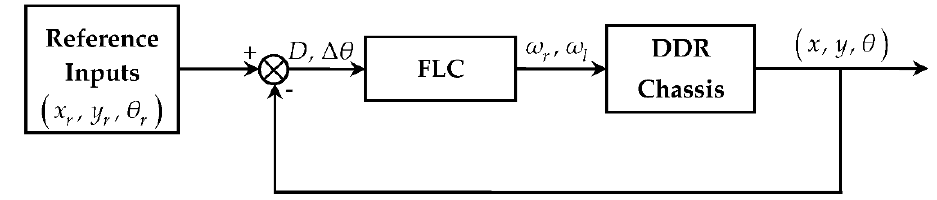
Figure 6. The close loop schema of the DDR using the fuzzy logic controller.